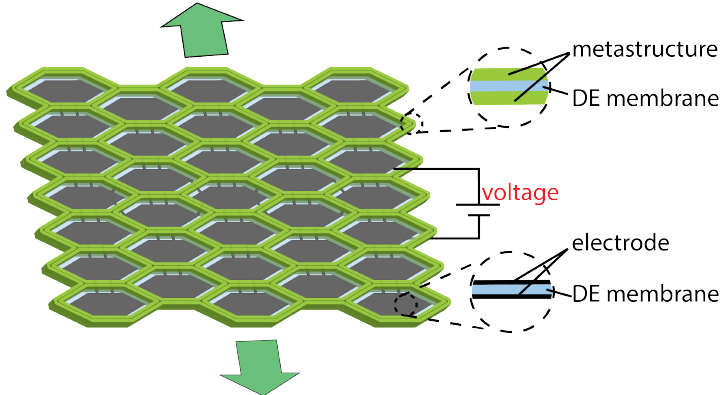
Figure 1. Schematic of a DE membrane coupled with honeycomb metastructures. When a high voltage is applied, the actuator outputs a unidirectional motion. The two insets illustrate the sections of the DE membrane sandwiched between metastructures and between electrodes,